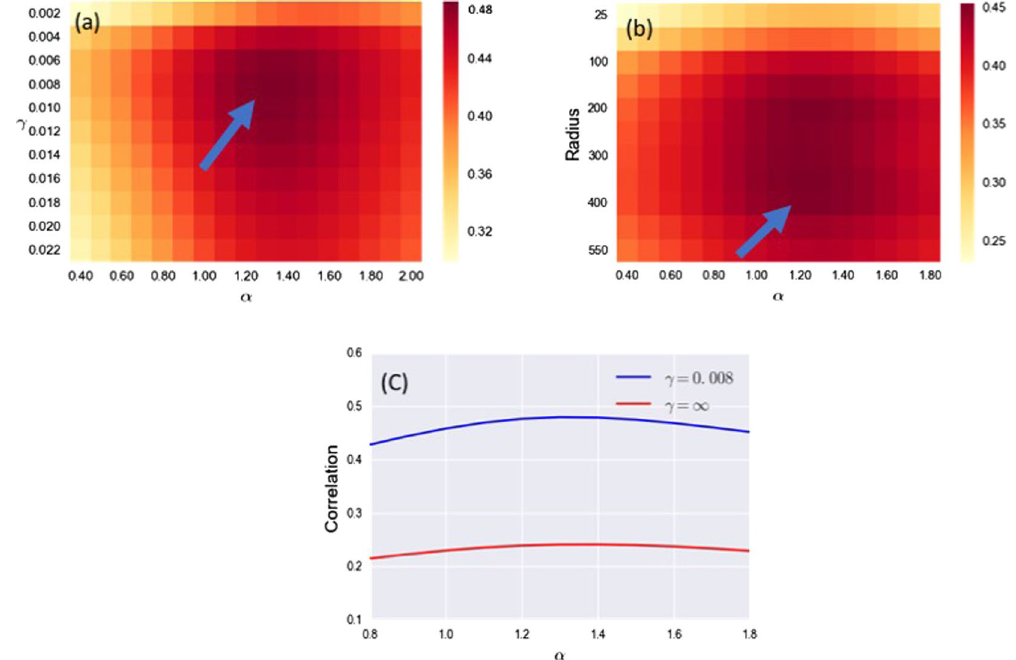
Figure 2. In this figure we present the results obtained comparing the retailer’s ratable value found in the VOA dataset, with the modeled turnovers Y ( α , γ ). In ( a ) we show a heat map of the correlation between the two quantities, we can see a clear maximum in the correlation for α max = 1.3 and γ max = 0.008. In ( b ) we show the correlation with the model of γ = 0, which implies that the attractiveness becomes = + ∑ α α